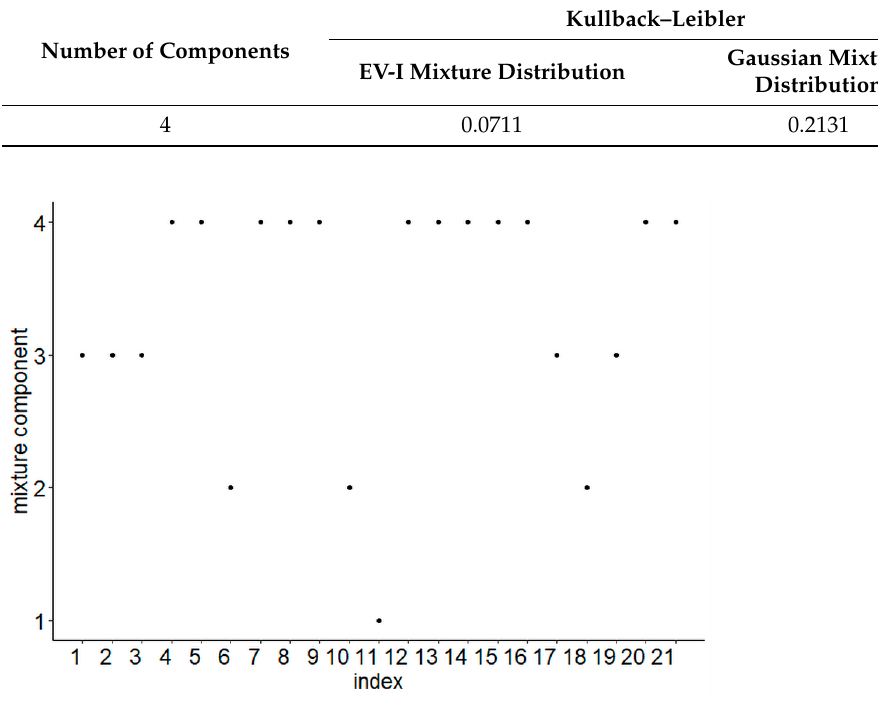
Table 10. Kullback–Leibler divergence using EV-I mixture and Gaussian mixture distributions for the DHF data in eastern Surabaya.